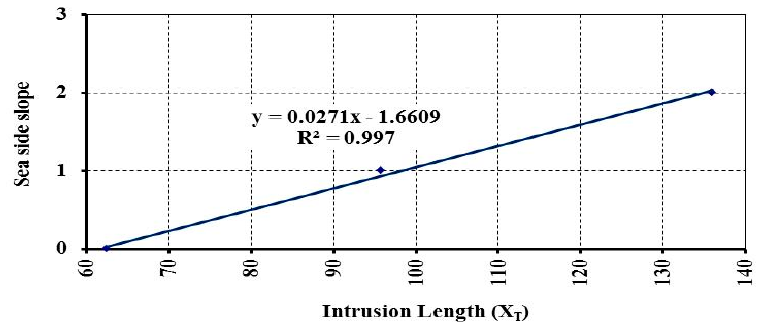
Figure 5. Relationship between seaside slope and intrusion length (X T ).